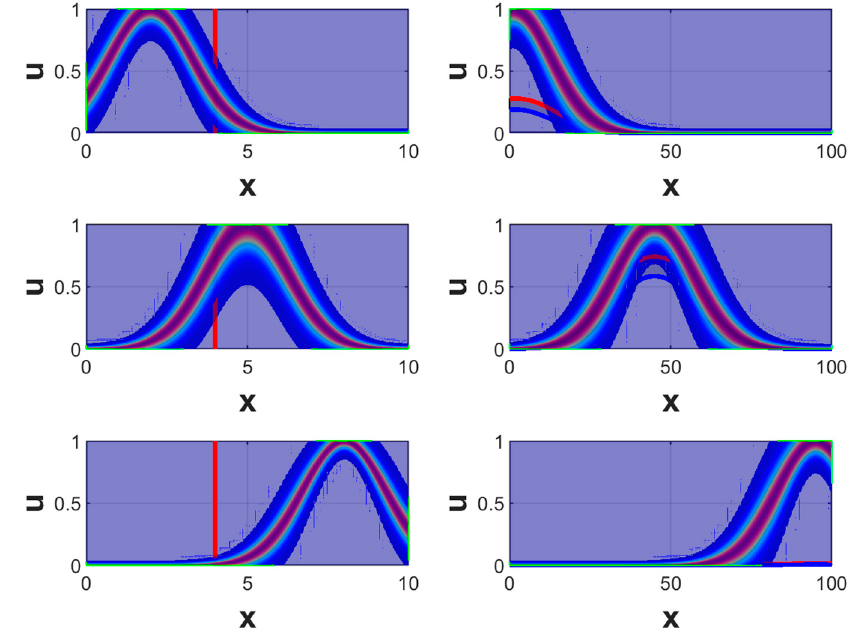
Figure 2. Illustration of the inference process for a value of x = 4.